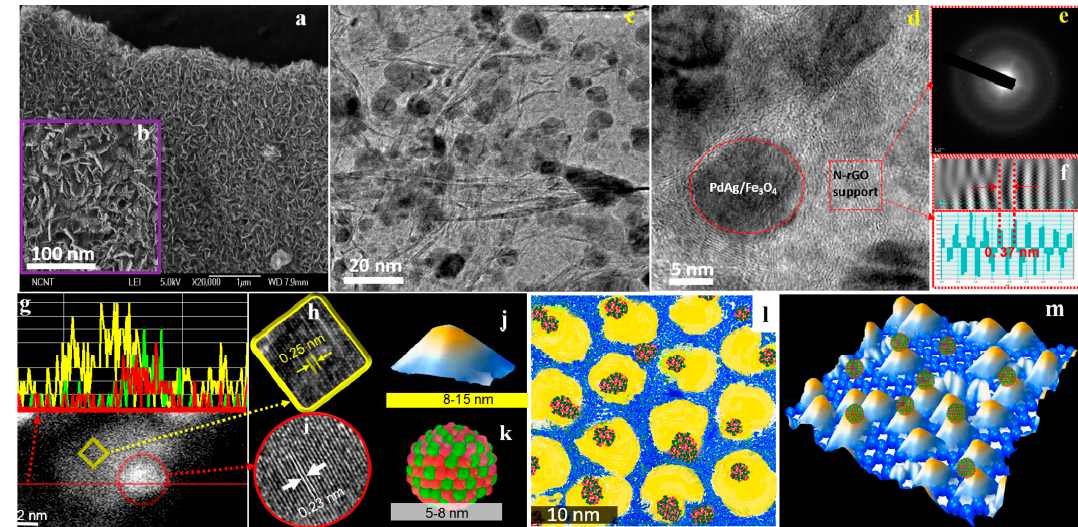
Figure 6. Microscopic analysis and proposed structure of Pd 50 Ag 50 /Fe 3 O 4 /N-rGO catalyst: ( a , b ) SEM images; ( c ) low-resolution TEM analysis; ( d ) high-resolution TEM analysis; ( e ) selected area electron diffraction pattern of N-rGO layer; ( f ) d spacing from stacked N-rGO layers; ( g ) dark field HAADF images with elemental line profile (yellow line, Fe; green line, Pd; red line, Ag); ( h , i ) CS-corrected TEM images of magnetite and PdAg nanoalloy; ( j , k ) proposed models for Fe 3 O 4 and PdAg nanoalloy; ( l ) 2D scratch art model (yellow, magnetite; blue background, N-rGO; and green/red cluster, PdAg alloy); ( m ) proposed 3D structural model. Reprinted with permission from [75].